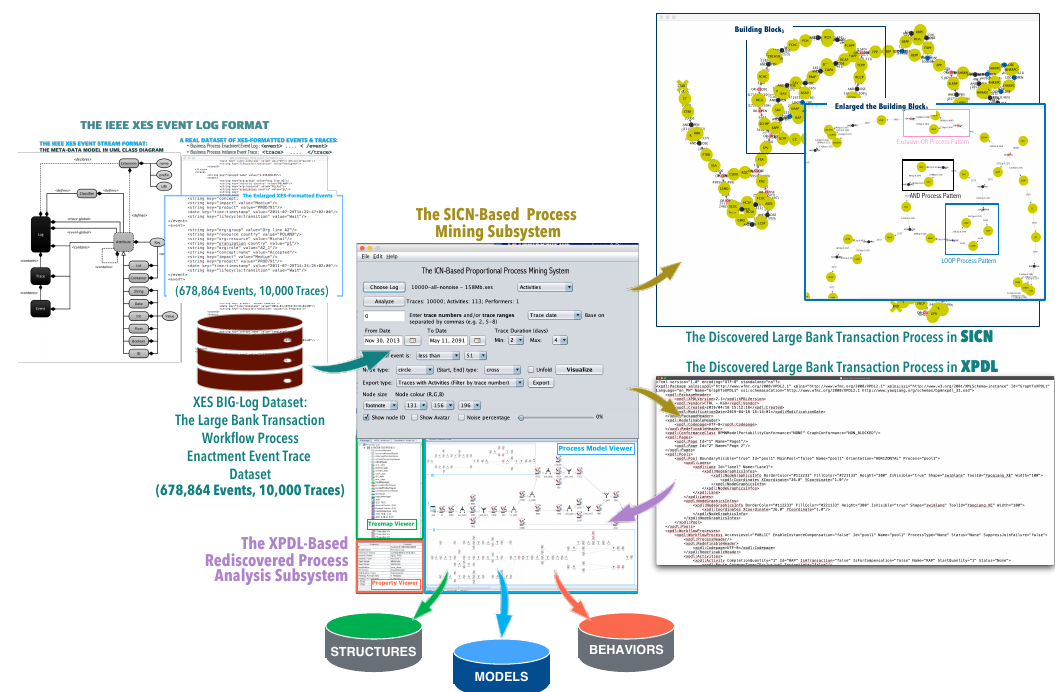
Figure 8. The implemented systematic framework of the integrated functional architecture.